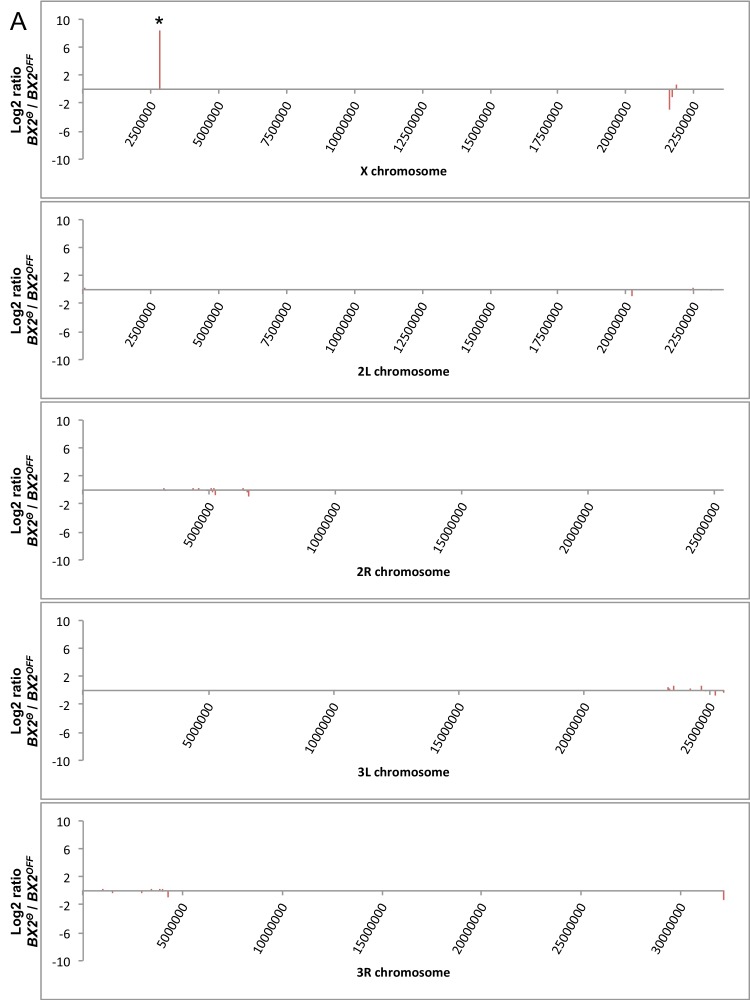
Mapping the genome for regions stably producing new piRNAs.(A) Unique piRNAs matching Drosophila chromosomes were kept only if they correspond to specific positions in BX2Θ compared to BX2OFF. The number of reads per specific positions was then resampled per windows of 50 kilobases. Background noise was reduced by considering only regions that match more than five reads per kilobase on average on both libraries. Log2 ratio of the number of specific reads from BX2Θ as compared to those from BX2OFF was plotted along chromosomes (50 kb window). Only one region on the X chromosome presents a high increase (log2 ratio >8.5, marked by an asterisk). (B) These small RNAs match exons of the white gene and correspond to piRNAs produced by P(lacW) transgenes corresponding to the BX2Θ locus. No other regions than BX2 stably produce new piRNAs.